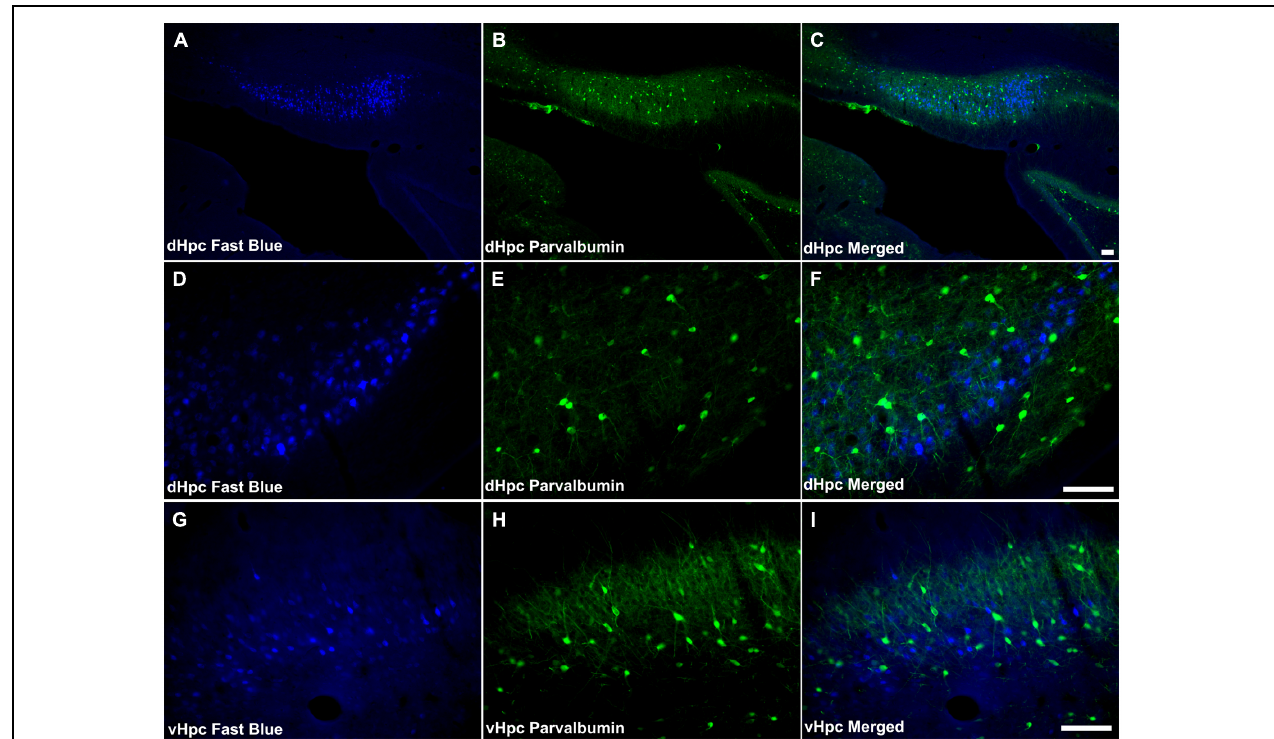
FIGURE 9 | Parvalbumin/hippocampal formation: (A,D,G) Fluorescent photomicrographs showing retrograde Fast Blue cell body label in the DS, Post, and VS, respectively. (B , E , H) show fluorescent PV immunoreactivity in respective sections while (C,F,I) show retrograde Fast Blue label and PV immunoreactivity superimposed. Dense